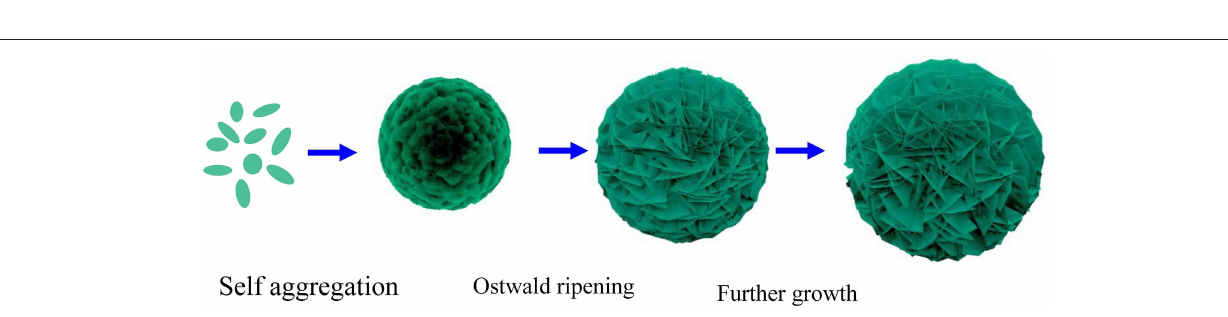
FIGURE 3 | Schematic illustration for the synthesis of α -Ni(OH) 2